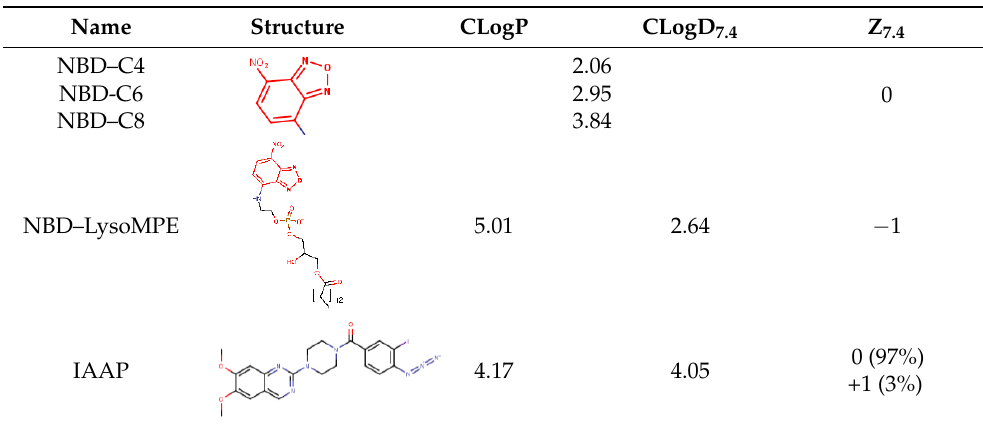
Table 1. Name, structure, and common molecular descriptors 1 for the P – gp ligands studied in this work.